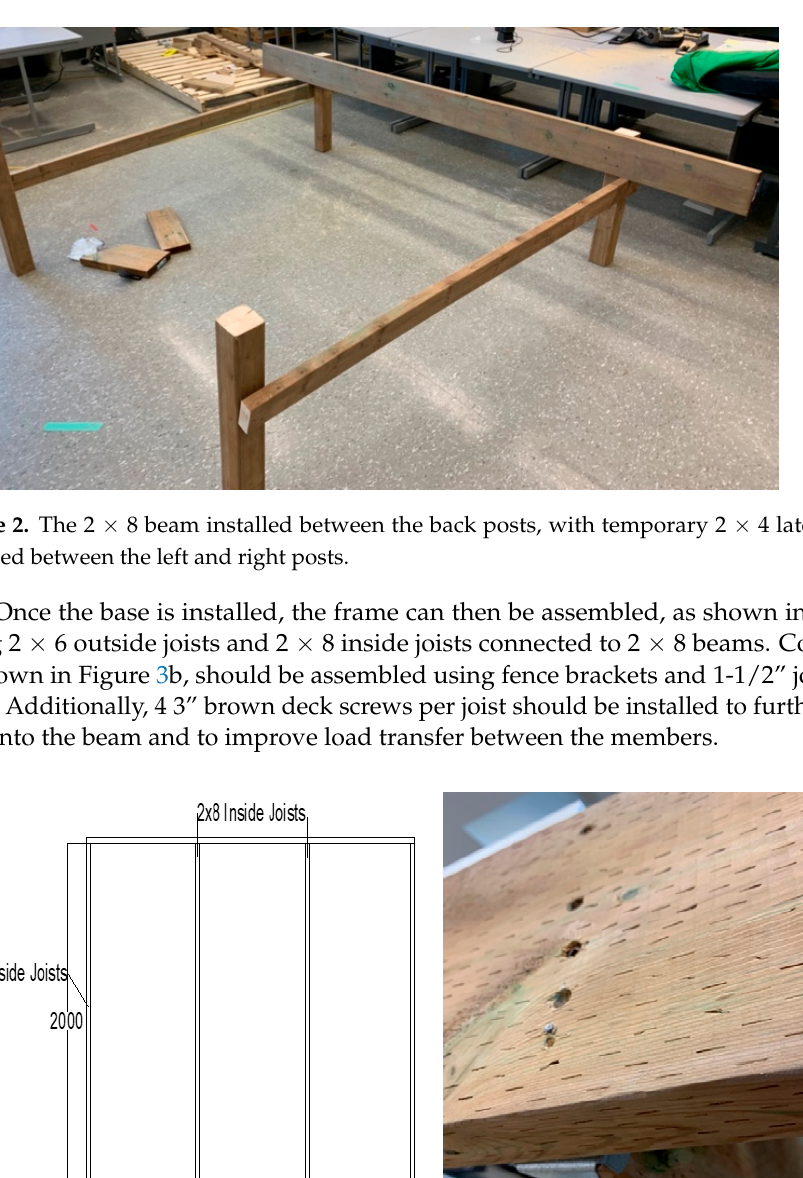
Figure 1. ( a ) Foundational installment of vertical posts, and ( b ) center-to-center spacing of vertical posts.